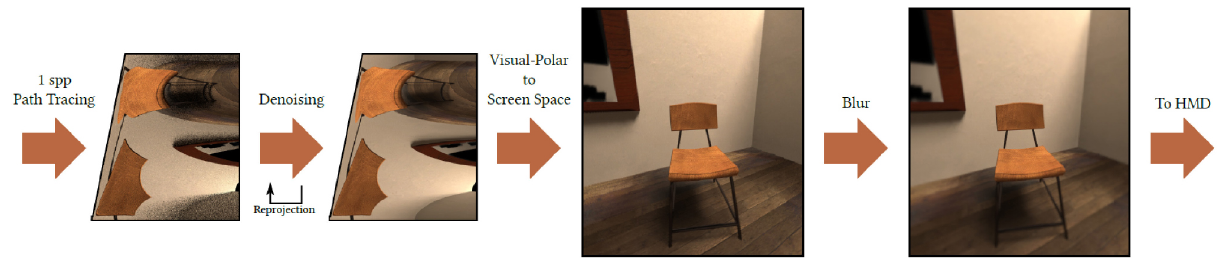
Fig. 11 Foveated real-time path tracing in visual-polar space proposed by Koskela et al. [33]. Rays were traced and rendering results denoised in a Visual-Polar space, the results were then mapped to the screen space, and finally the Guassian blur was performed to generate the final HMD rendering result. Ray tracing and denoising in Visual-Polar space increase both by 2.5 × faster. Reproduced with permission from Ref. [33], c (cid:13) The Author(s) 2019. real